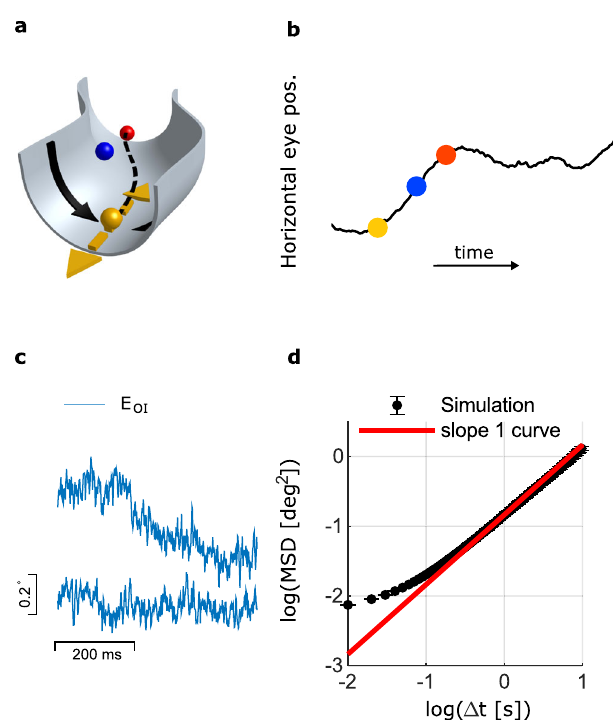
Fig. 4 Effect of intrinsic noise in a continuous attractor neural network. a Schematic illustration of a continuous attractor manifold. Steady states of the dynamics can be conceptualized as minima of an energy function de fi ned in the neural state space 30 . For visualization purposes, two dimensions of the neural state space are depicted in the plane, and the vertical dimension represents the energy. Each point along the curved valley (dashed line) maps to a speci fi c horizontal eye position. During fi xation the state of the network is set initially to represent a particular eye position (yellow circle). Noise in the activity of neurons within the network dynamically perturbs the state of the network. Such perturbations generally decay (black arrows), but perturbations along the fl at direction (dashed yellow arrows) do not decay, causing motion along the valley that builds up over time in the form of diffusive motion 33 . The state of the network at two time points after initialization is depicted by the blue and red balls. The projection on the dashed line determines the horizontal eye position ( b ). b The horizontal eye trajectory resulting from the noise-driven diffusive motion. c Examples of two fi xational eye trajectories that emerge from the simulation of the oculomotor integrator model network, with neural noise. d The MSD statistics of 100 eye trajectories as in ( c ). At suf fi ciently large time lags the motion follows the statistics of simple diffusion, with a logarithmic slope equal to 1 (red